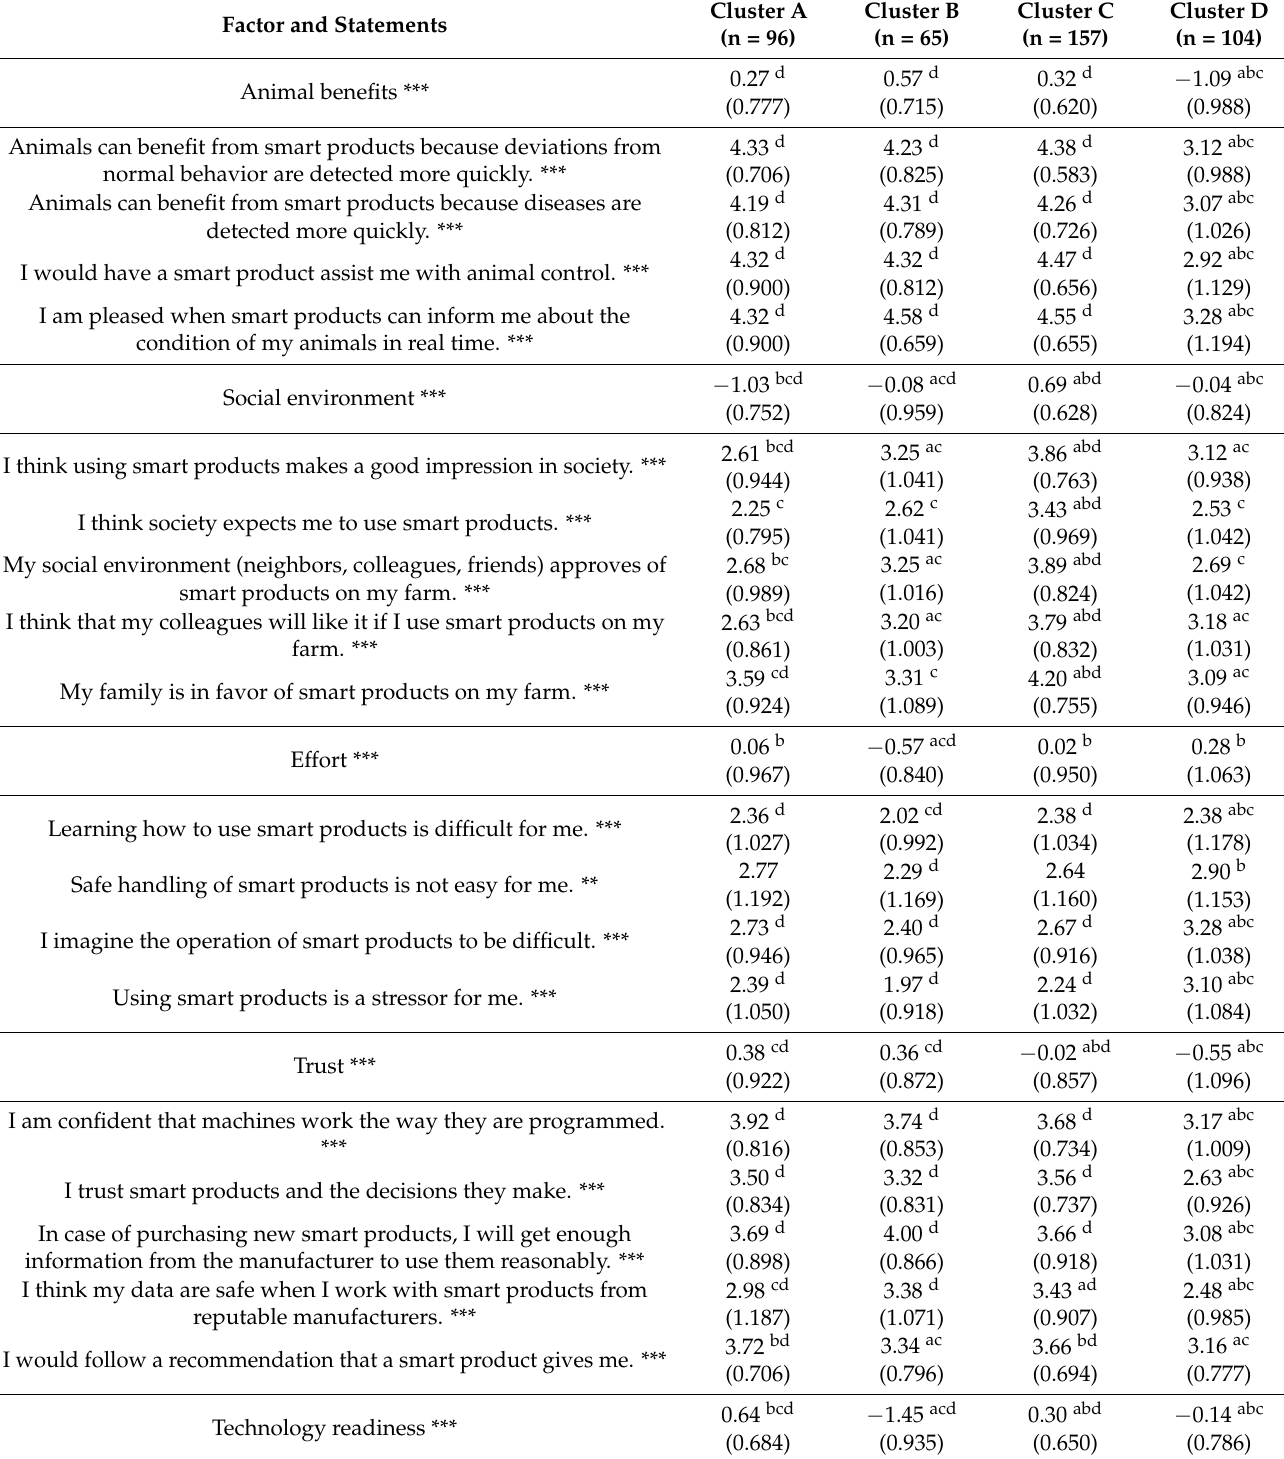
Table 2. Results of the cluster